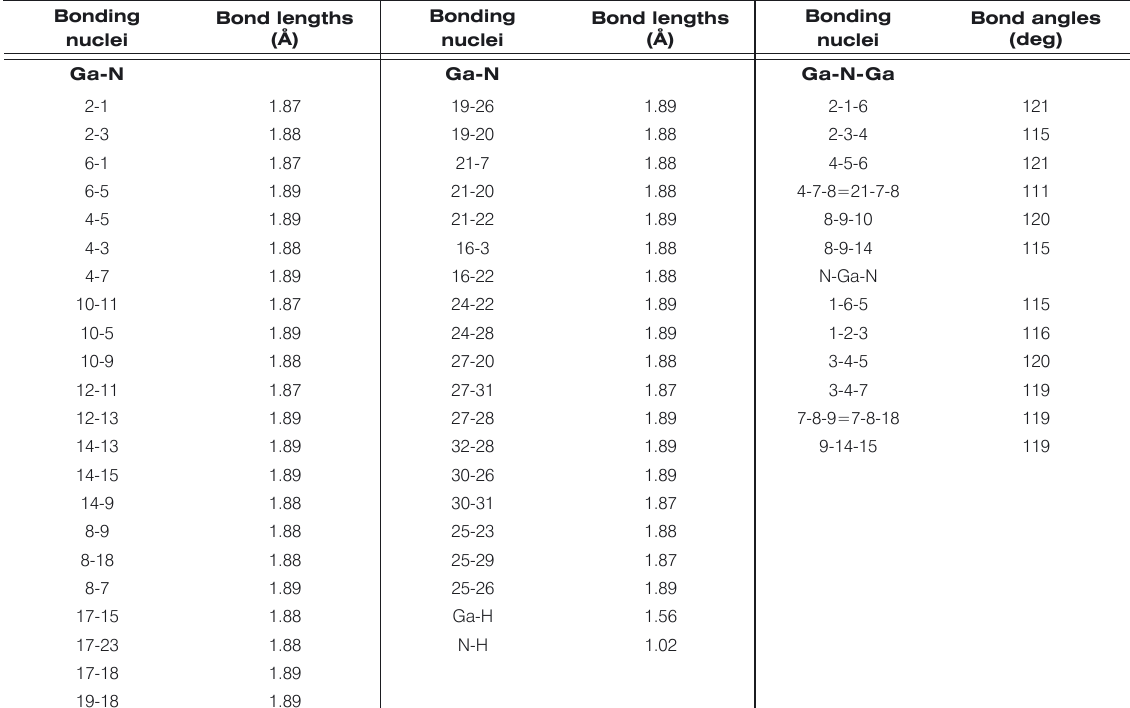
Bond angles (deg)